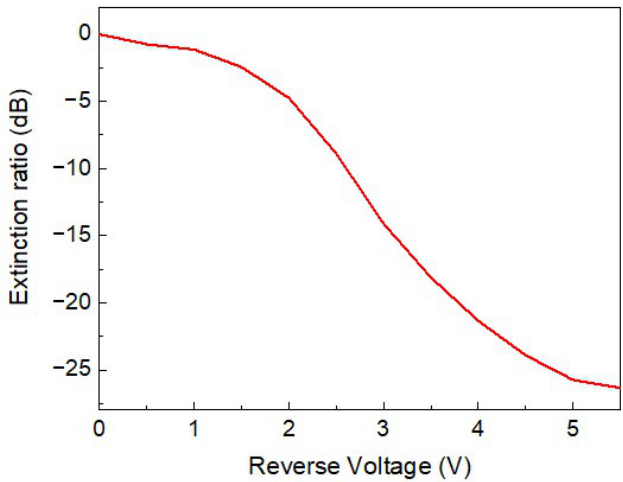
Figure 5. Extinction ratio of the EML laser versus the modulation bias. 8510C vector network analyzer. A Finisar U2T-XPDV2320R photodetector was used for